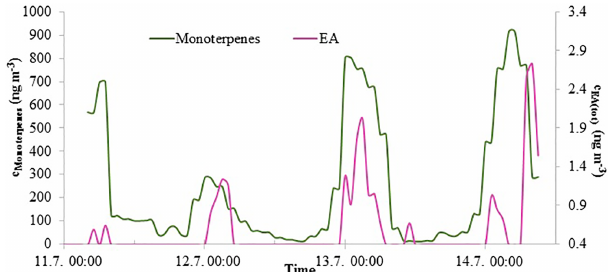
Figure 5. EA(tot) and monoterpene concentrations in Hyytiälä in July 2015. The EA(tot) concentration axis starts from 0.36ngm − 3 , because values under that are below the detection